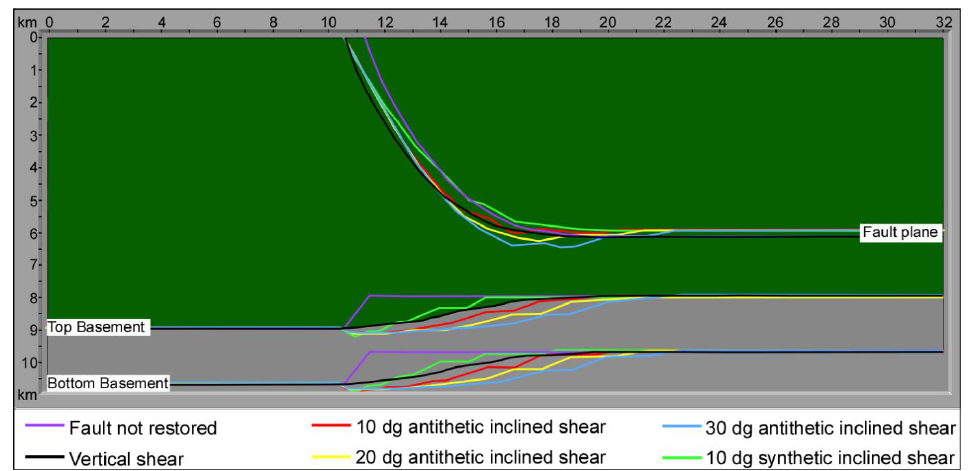
Figure 14. Resulting basin geometries after fault slip with the tested fault restoration methods. The different colored lines represent the resulting geometry of fault plane and Top and Bottom Basement after fault is restored by the six tested restoration methods. dg = degrees.